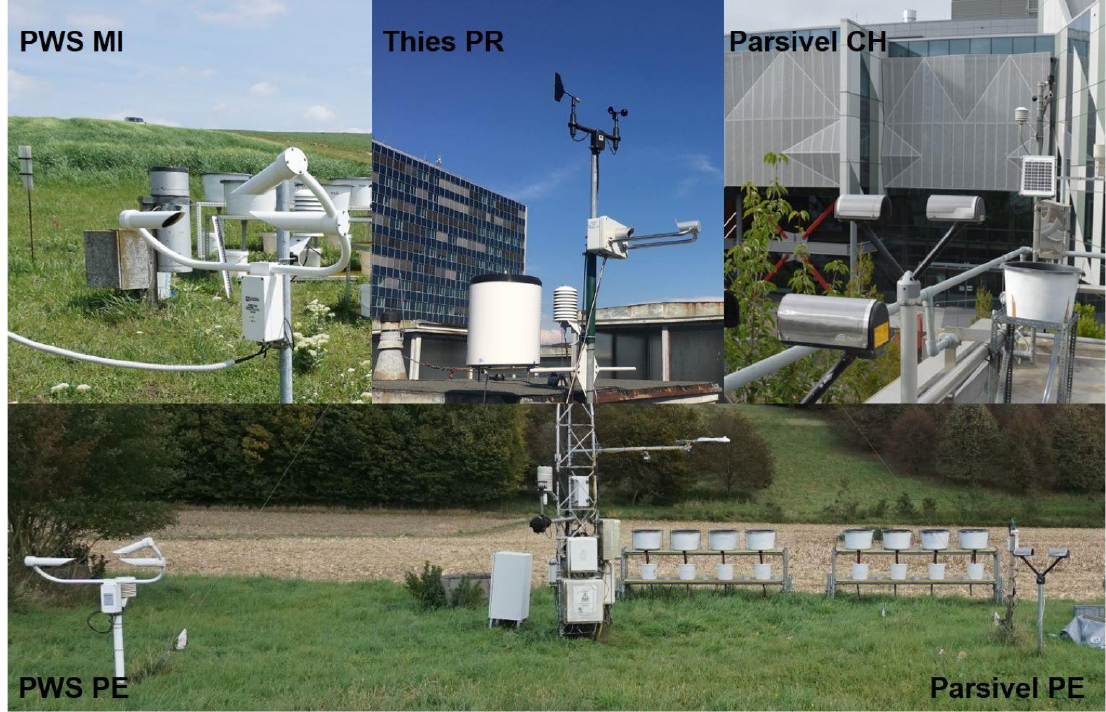
Figure 1. Disdrometers at the measurement sites Mistelbach (MI), Petzenkirchen (PE), Prague (PR) and Christchurch (CH) (a photo of the Thies Rauchenwarth (RA) site was not available).